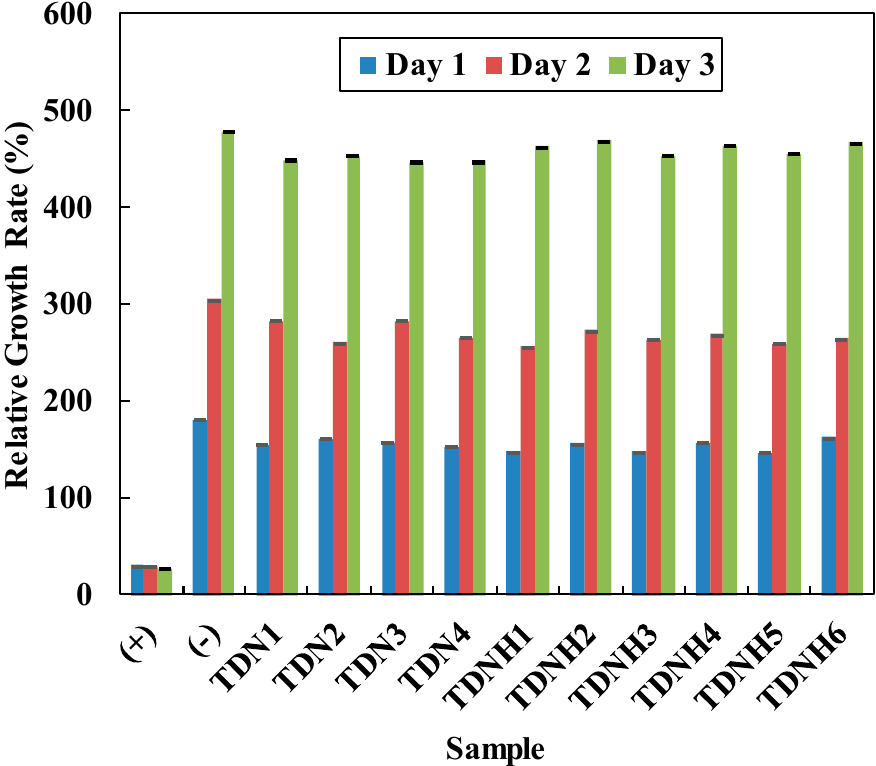
Figure 6. Relative growth rate (RGR) of silicone hydrogel specimens during 3 cultured days with L929 cells of lens samples.